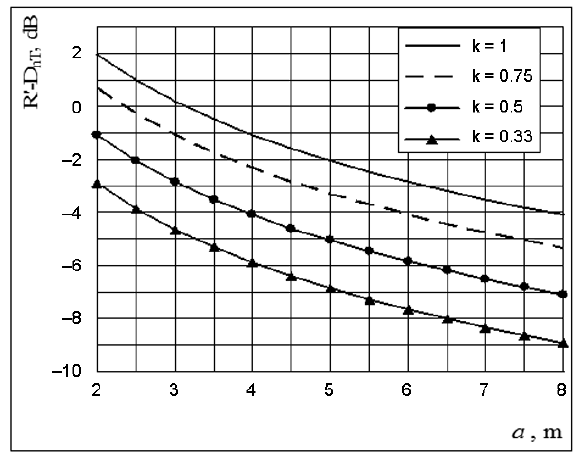
Fig. 2. Dependency of the difference ( R’ – D n T ) on the room dimension a (modified from Jagniatinskis, Fiks 2004)